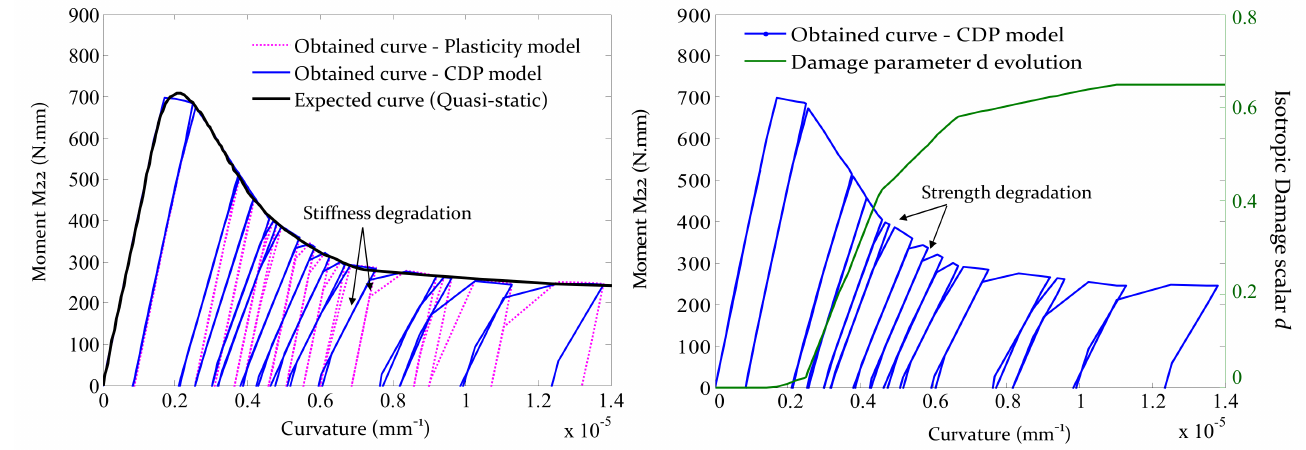
Figure 10. Uni–directional cyclic behaviour (Note: only the positive moments are plotted, i.e., the part of the unloading branch for negative bending moments has been disregarded for the sake of